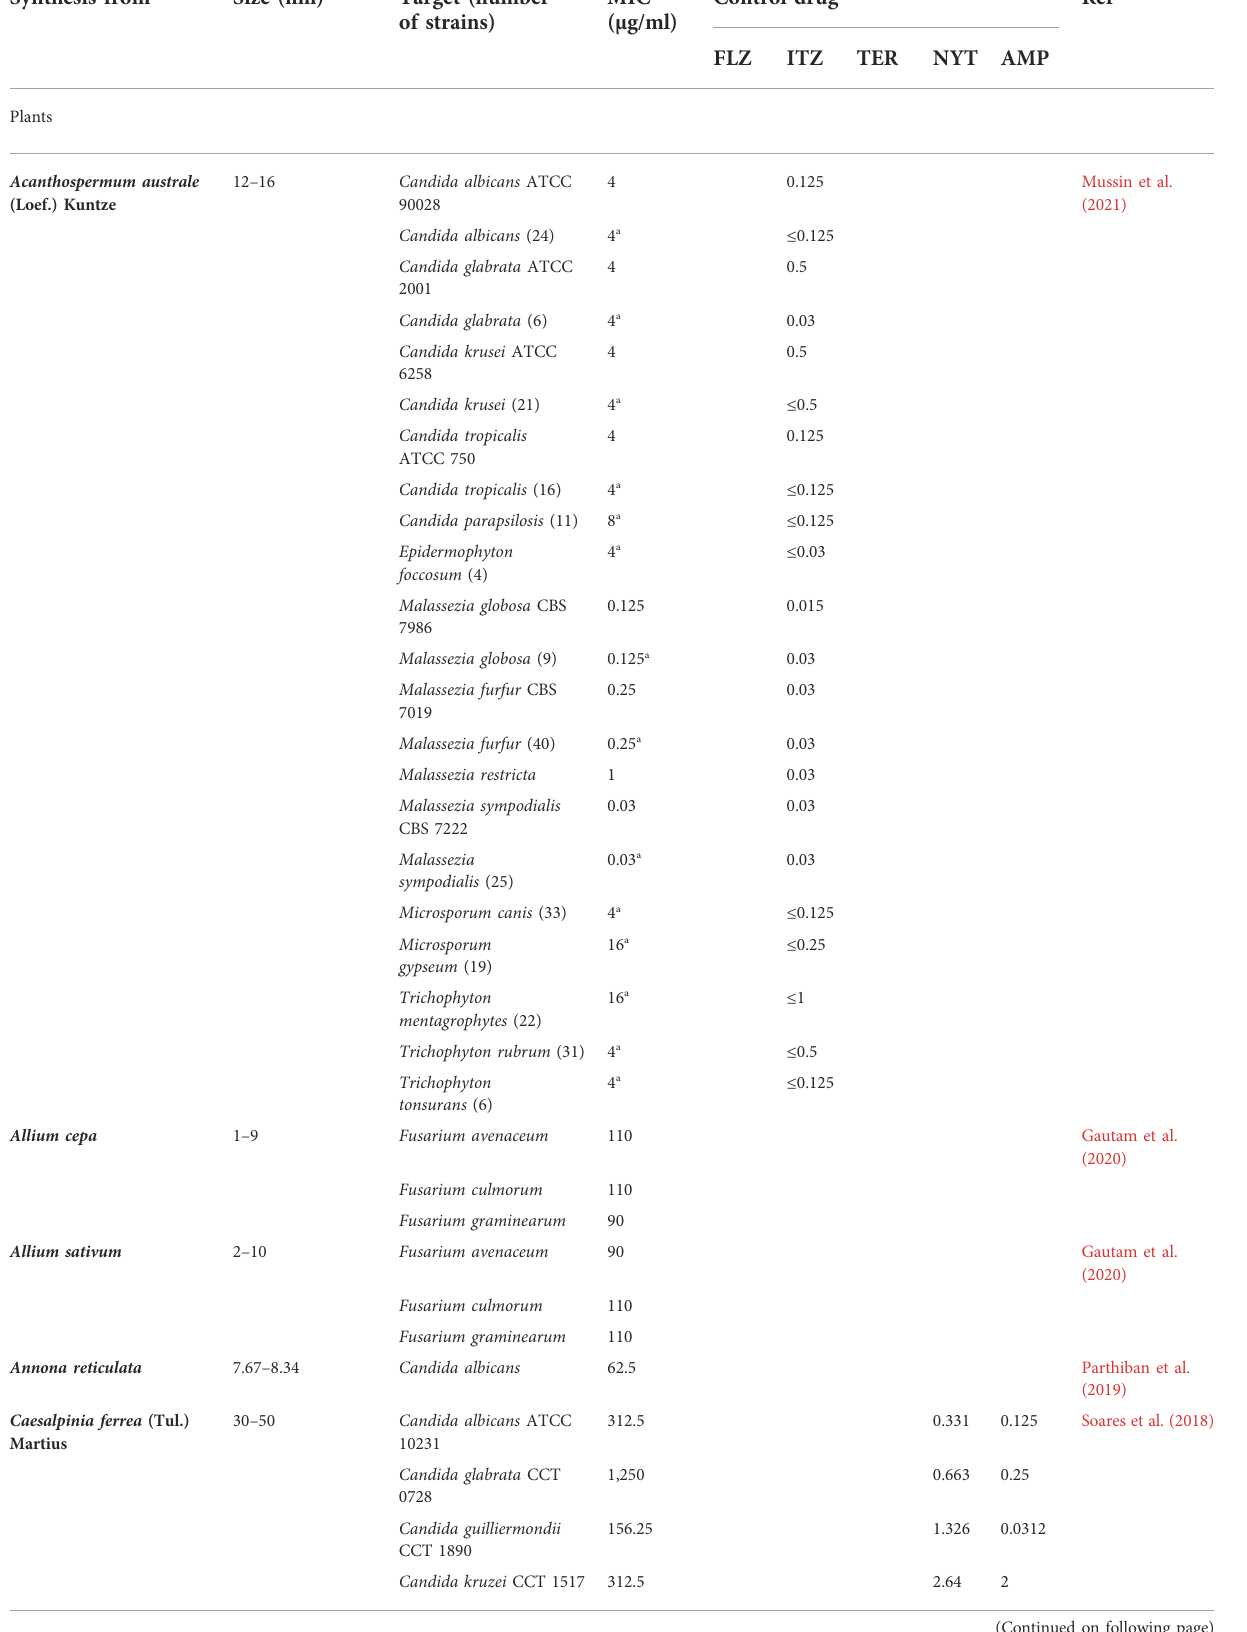
TABLE 1 Antifungal activity of biogenic AgNPs. Synthesis from